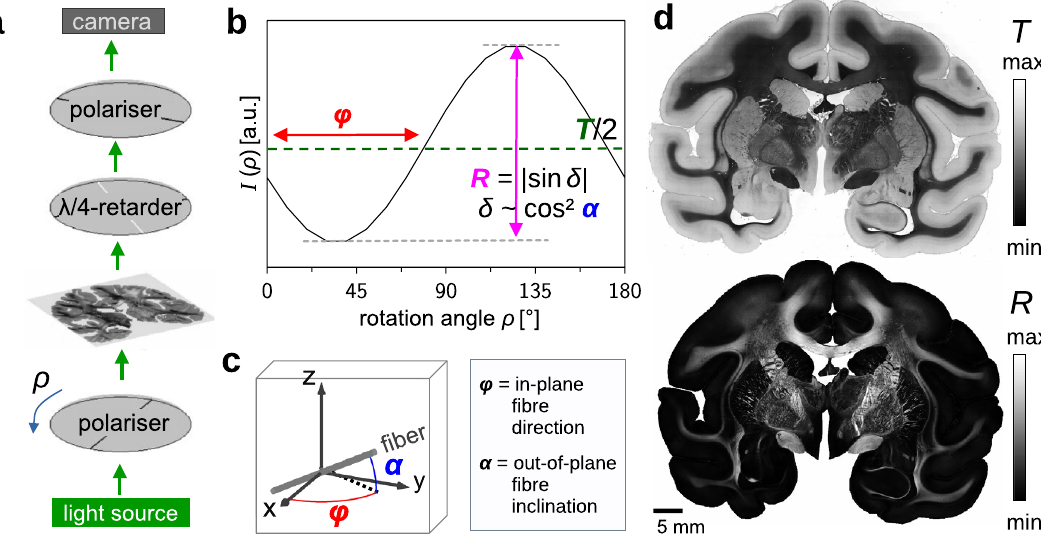
Figure 1. 3D-PLI measurement and analysis. ( a ) Schematic drawing of the set-up (not to scale). ( b ) Transmitted light intensity of one image pixel for different rotation angles ρ of the polariser. The transmittance ( T ) and retardation ( R ) are obtained from the average and normalized amplitude of the signal, respectively. ( c ) Definition of the in-plane fibre direction ϕ and the out-of-plane fibre inclination α , which are derived from the phase and amplitude of the signal, respectively, as indicated in ( b ). ( d ) Transmittance image (top) and retardation image (bottom) for the coronal vervet monkey brain